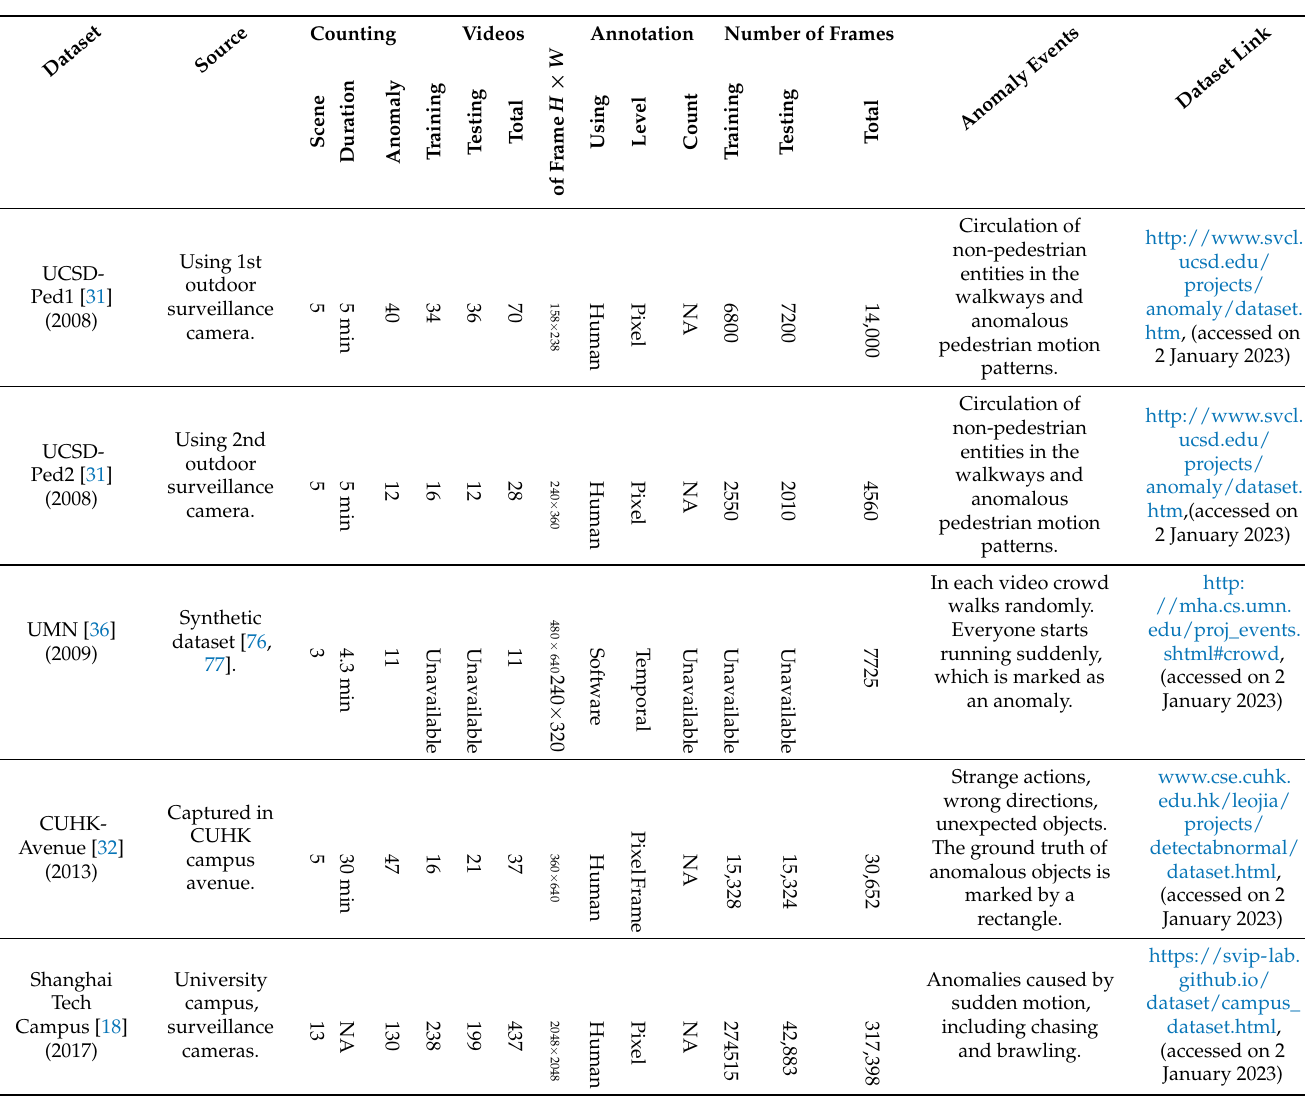
Table 3. Comparison of various specifications of crowd datasets and their available web links. H ⇒ height, W ⇒